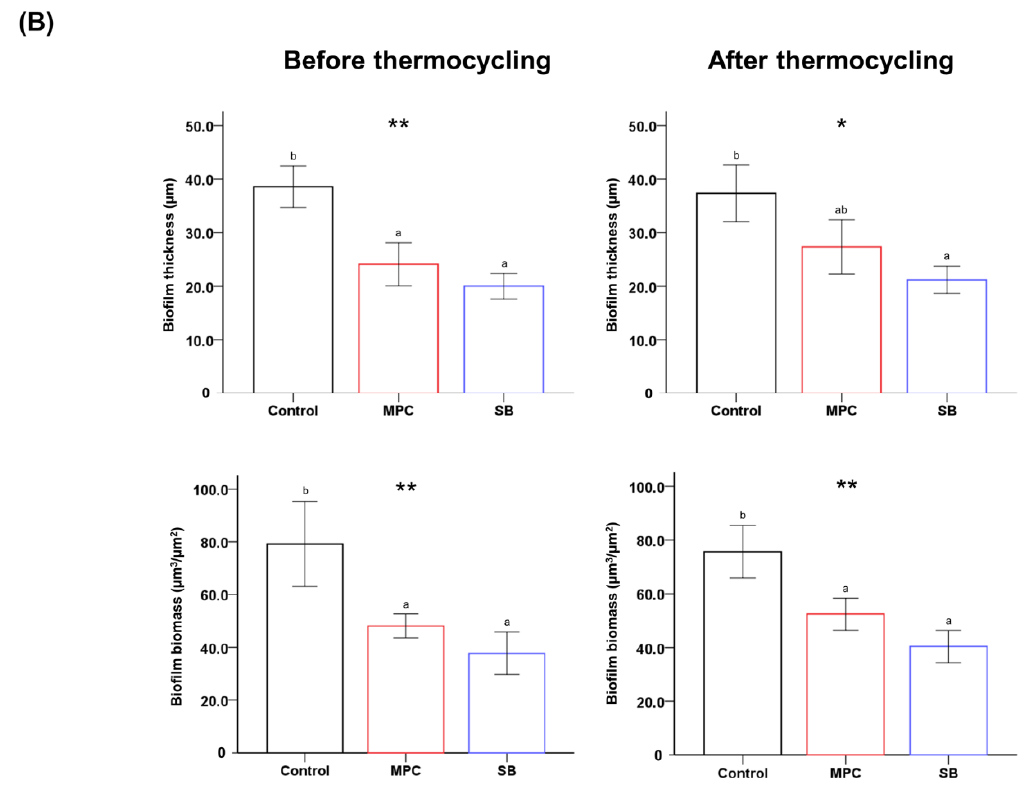
Figure 5. ( A ) Live/dead staining images of biofilms attached to the surfaces of poly(methyl methacralyate) (PMMA) before (Control) and after the addition of 2-methacryloyloxyethyl phosphorylcholine (MPC) or sulfobetaine methacrylate (SB). Scale bar is 100 µm. ( B ) Quantitative analysis of the thickness and biomass of the biofilms. Different lowercase letters above the bars indicate significant differences by post-hoc Tukey’s test. ** p < 0.01, * p < 0.05 for comparisons between PMMA with and without the zwitterion analyzed by one-way analysis of variance (ANOVA). Results obtained before thermocycling (left) and after thermocycling (right) are shown.